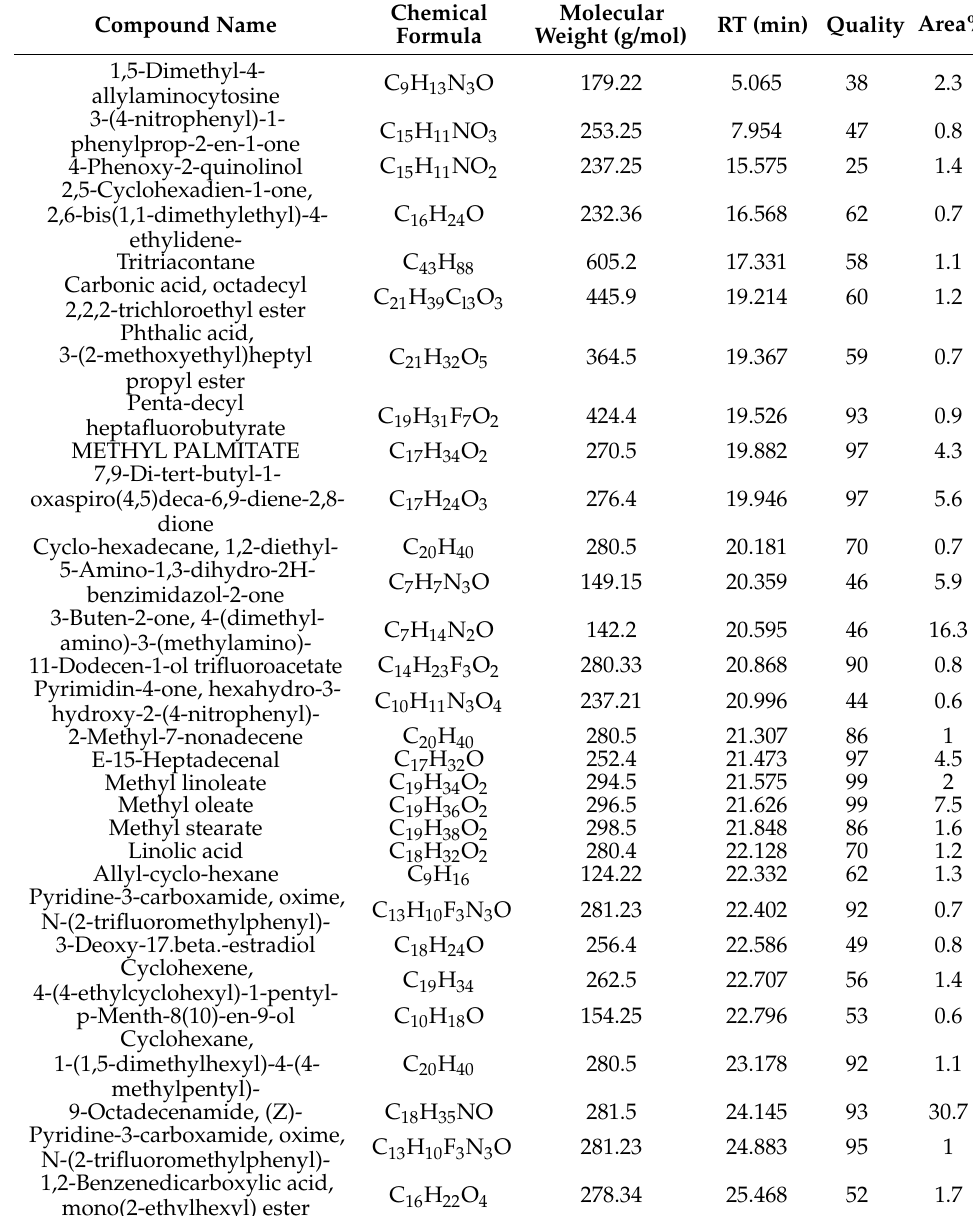
Table 5. The GC-MS analysis of the crude hexane extract obtained from wet mycelial biomass produced using ascospores of T . nivea